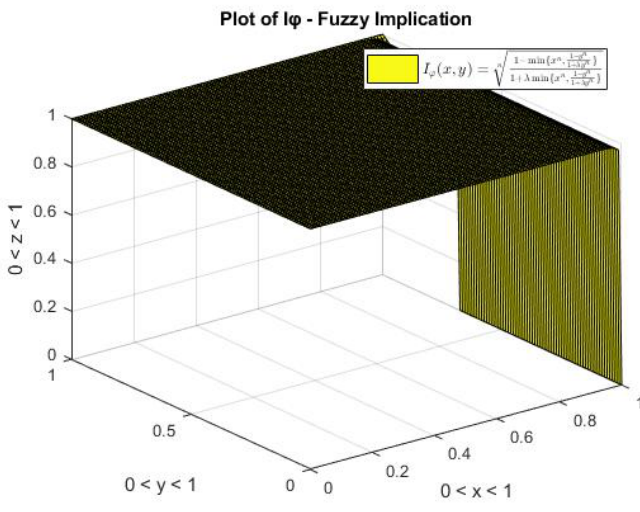
Figure 7. I-implication generated from I ( x , y ) = N ( T ( x , N ( y ))) using an automorphism